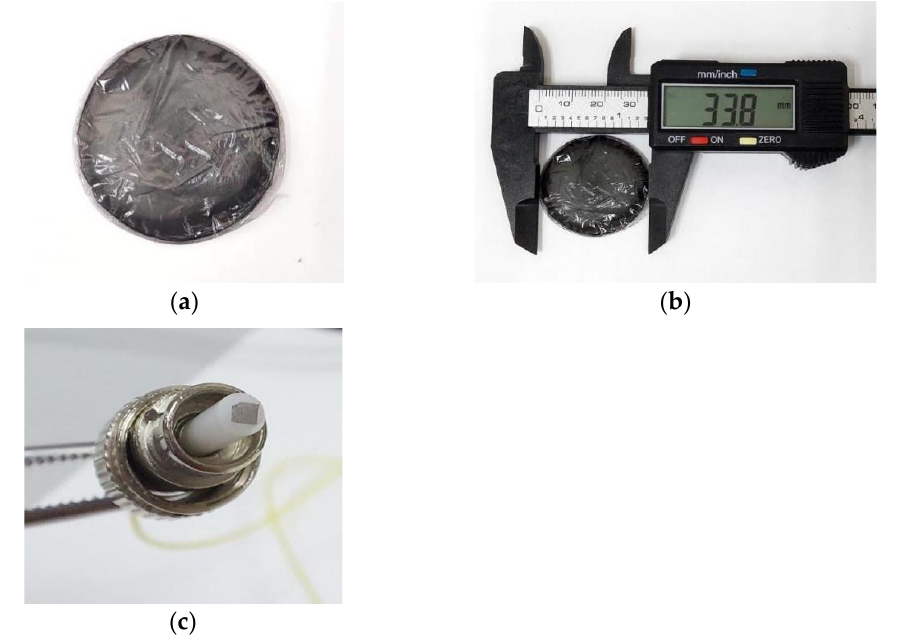
Figure 2. ( a ) Peeled Nb 2 AlC film ( b ) the measured Nb 2 AlC film diameter ( c ) the fabricated Nb 2 AlC film attached onto a fiber ferrule.